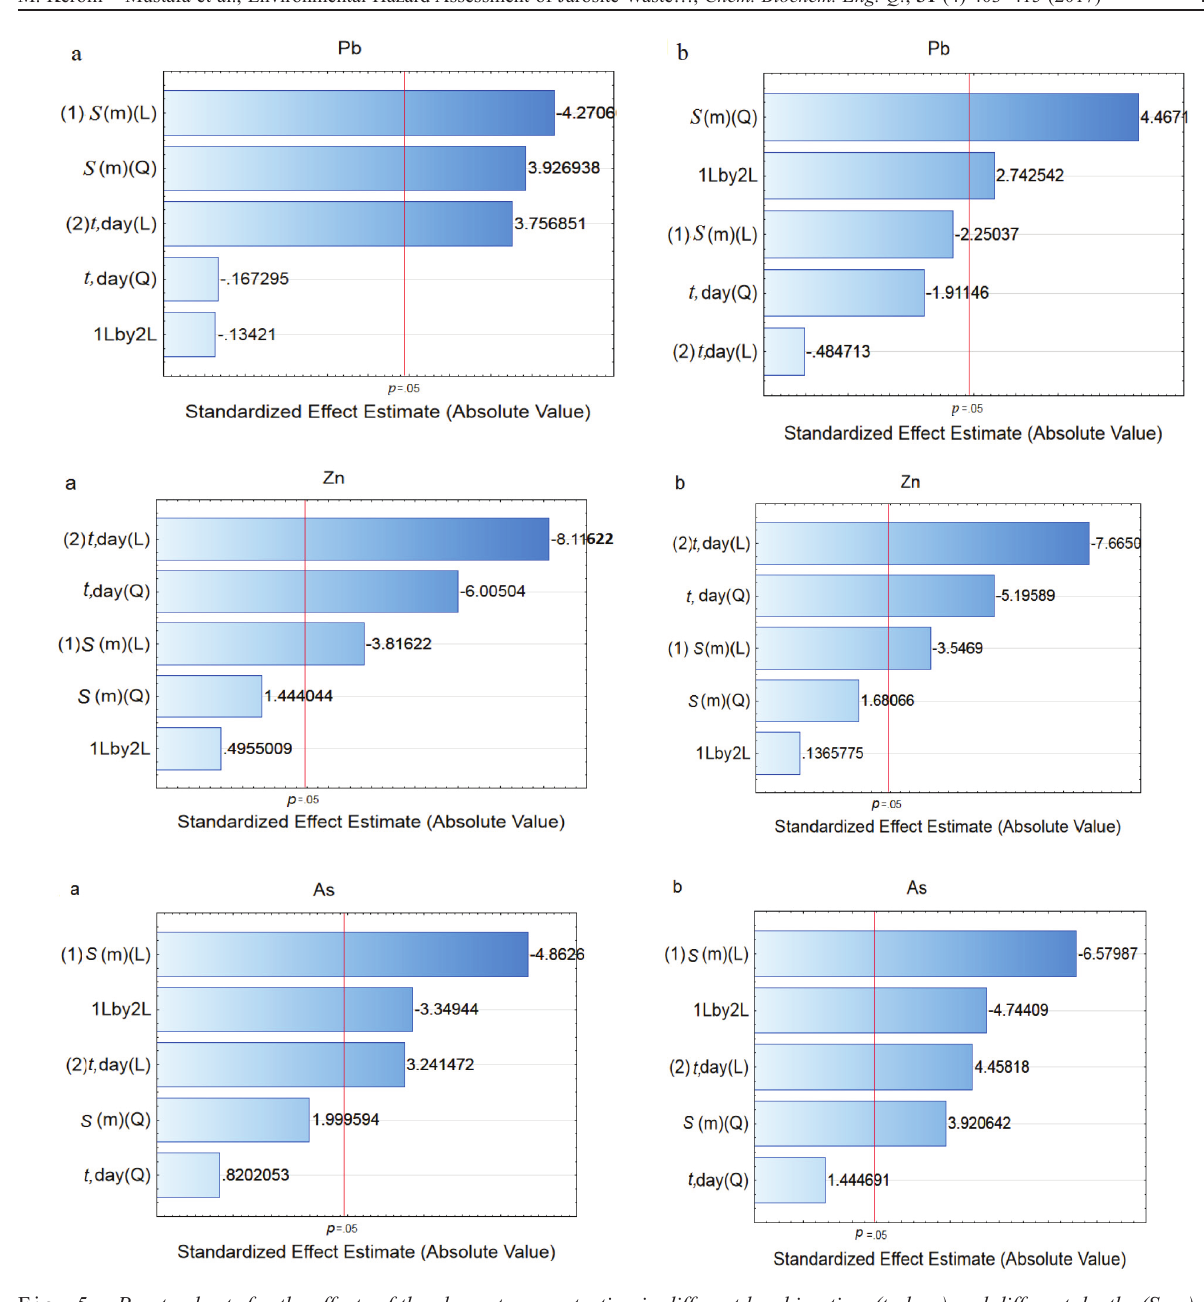
Fig. 5 – Pareto charts for the effects of the element concentration in different leaching time (t, days) and different depths (S, m), (a) Cd, Cu, Mn, Ni, Pb, Zn, and As leaching in deionized water, and (b) Cd, Cu, Mn, Ni, Pb, Zn, and As leaching in synthetic acid